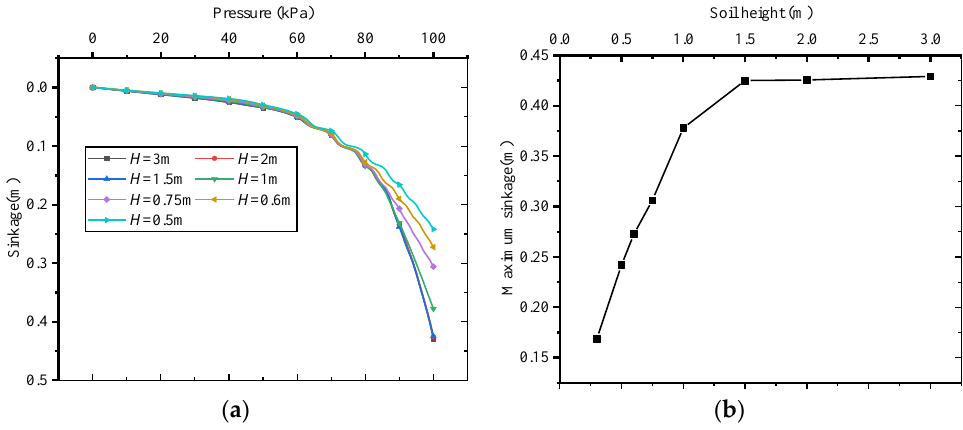
Figure 25. ( a ) Pressure-sinkage curves of different soil height and ( b ) maximum sinkage comparison at 100 kPa case.